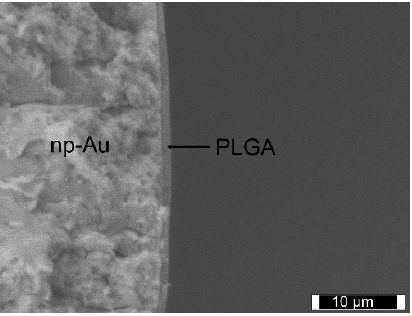
Figure 10. SEM image showing cross-section of np-Au@PLGA/RAPA obtained by single dip coating. The thickness of PLGA coating is ≈ 1.5 µm. Scale bar:10 µm.